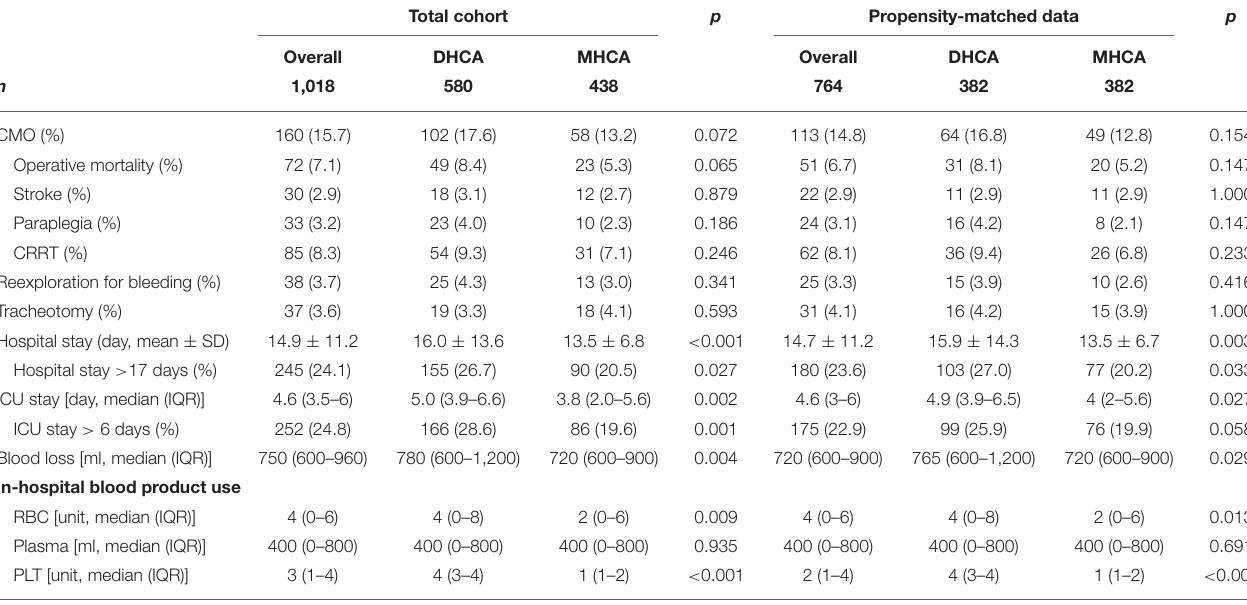
TABLE 3 | Outcome